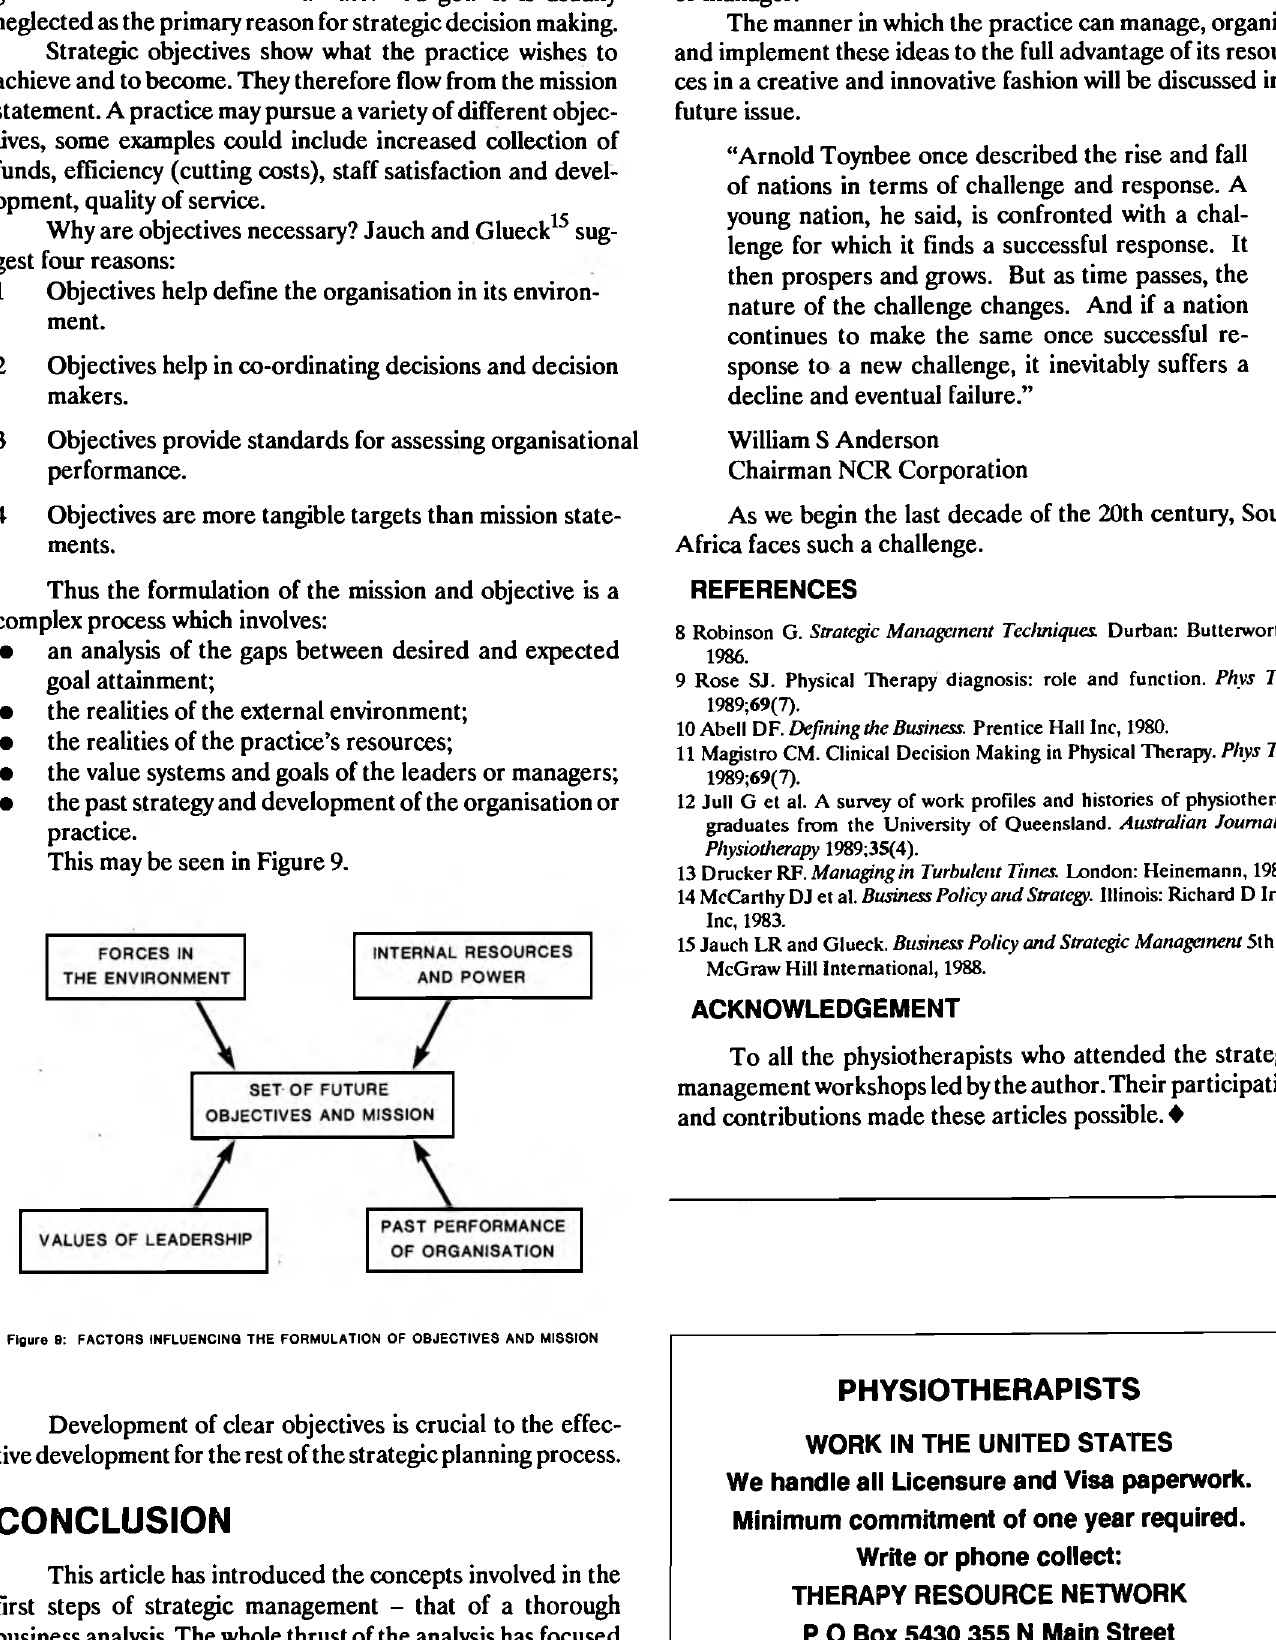
Development of clear objectives is crucial to the effec­ tive development for the rest of the strategic planning